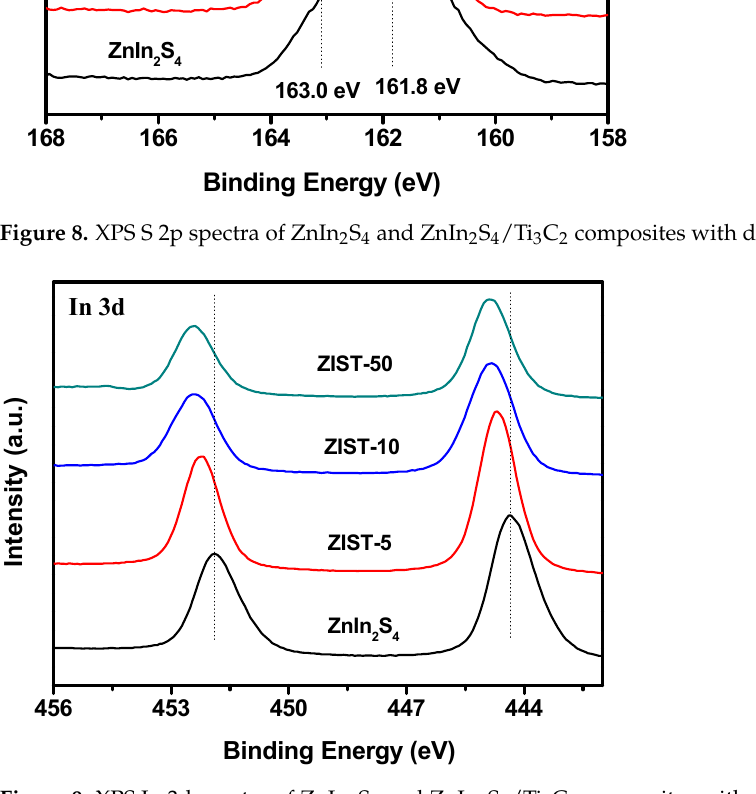
Figure 9. XPS In 3d spectra of ZnIn 2 S 4 and ZnIn 2 S 4 /Ti 3 C 2 composites with different Ti 3 C 2 content. DRS was used to measure the light harvesting capability of the photocatalyst sam- ples. A clear red shift was exhibited for the ZnIn 2 S 4 /Ti 3 C 2 nanocomposites, and their ab- sorption in the visible light region was significantly enhanced compared with pure ZnIn 2 S 4 (Figure 11). As the Ti 3 C 2 content increased, the absorption intensity of ZnIn 2 S 4 /Ti 3 C 2 gradually increased due to the full-spectrum absorption of dark Ti 3 C 2 [23]. Because of the high efficiency of photothermal conversion of Ti 3 C 2 [22], it is possible to activate the catalyst by converting the light energy into heat to promote the surface cata- lytic reaction [29].